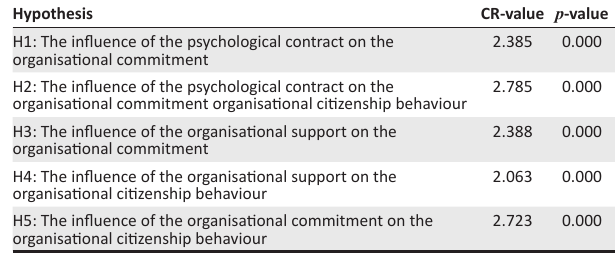
TABLE 3: Hypotheses